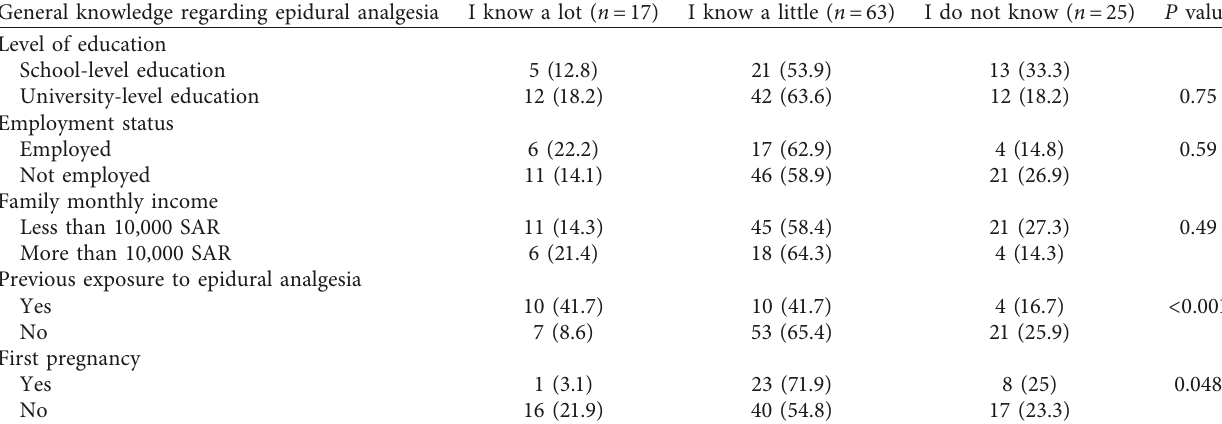
Table 2: Demographic characteristics and general knowledge regarding EPA.